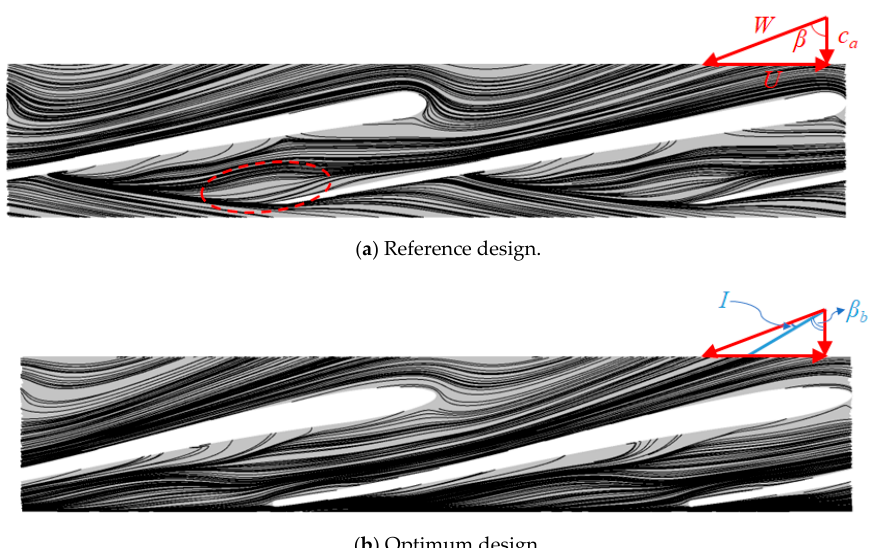
Figure 18. Streamlines at 50% span.